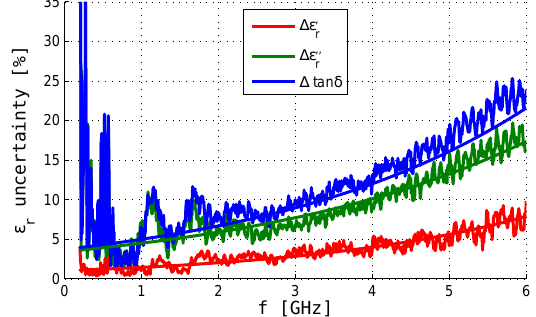
Figure A2. Uncertainty of methanol permittivity (T = 20.6 ◦